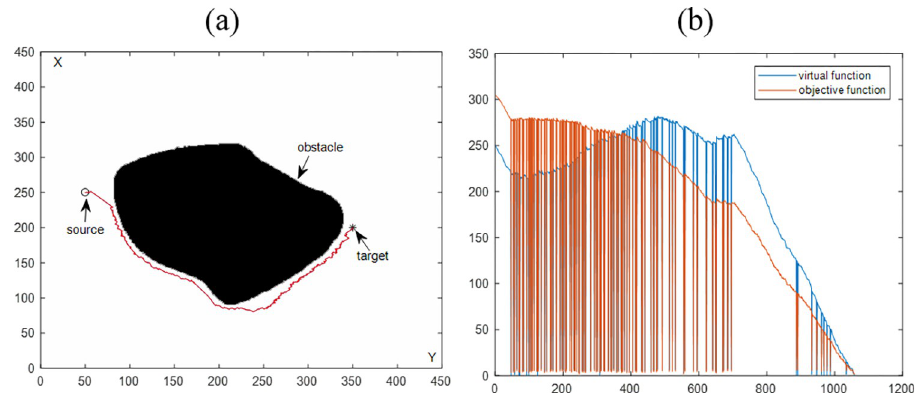
Fig 6. Path planning results are synthesized by the VBAS algorithm to avoid a single irregular obstacle. (a) Motion results in a 2D plane. (b) Relationship between function and number of iterations.